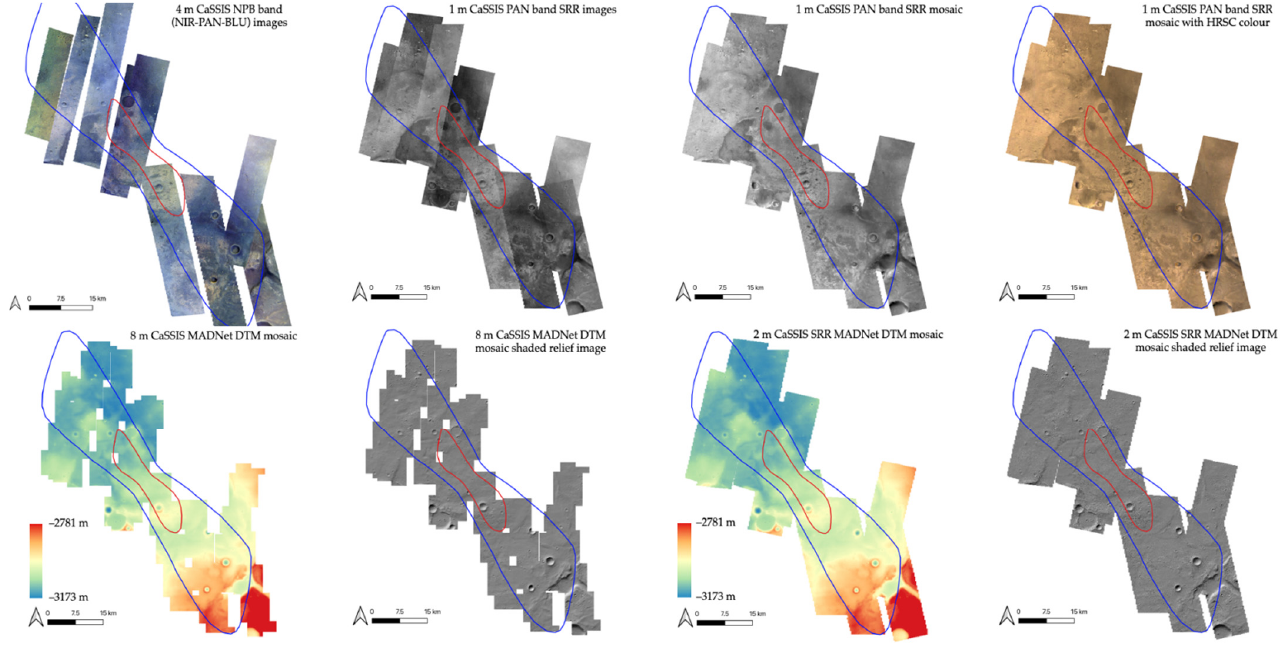
Figure 5. Overview maps of the 4 m/pixel CaSSIS NPB (NIR-PAN-BLU) band colour images, the resultant 1 m/pixel CaSSIS PAN band SRR single-strip images, 1 m/pixel CaSSIS SRR image mosaic, 1 m/pixel CaSSIS SRR image mosaic with HRSC colour, 8 m/pixel CaSSIS MADNet DTM mosaic, the shaded relief image (330° azimuth, 30° altitude, 2× vertical exaggeration) of the 8 m/pixel CaSSIS MADNet DTM mosaic, 2 m/pixel CaSSIS SRR MADNet DTM mosaic, and the shaded relief image (330° azimuth, 30° altitude, 2× vertical exaggeration) of the 2 m/pixel CaSSIS SRR MADNet DTM mosaic, over the 1-sigma (red) and 3-sigma (blue) ellipses of the ExoMars Rosalind Franklin rover’s planned landing site at Oxia Planum.